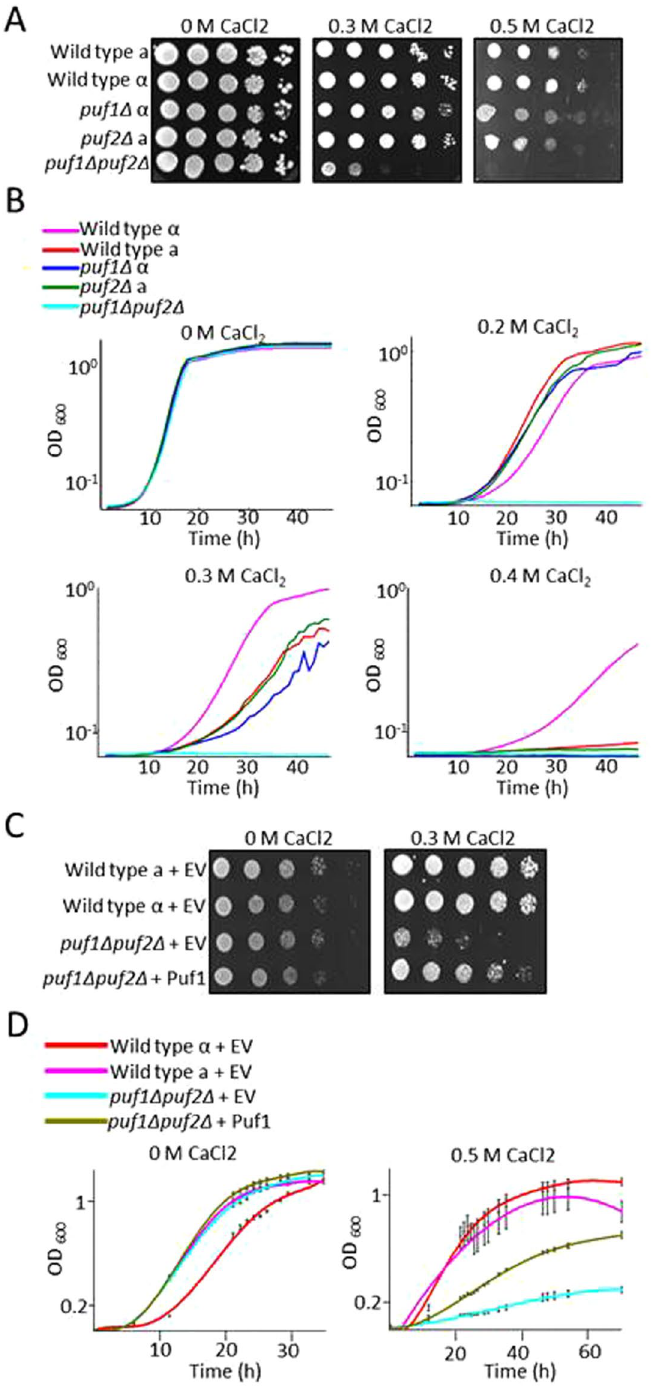
Figure 2. Puf1 and Puf2 deletions show distinct effects during growth under CaCl 2 stress. ( A ) Cells were grown in YPD to the stationary phase and diluted to OD 600 = 1. Five µ l of this suspension and four subsequent 10-fold serial dilutions of wild-type mating type ‘a’ (WT a)(yA635), wild-type mating type α (WT α , yA995), puf1 Δ (yA1382), puf2 Δ (yA637) and puf1 Δ puf2 Δ (yA639) strains were spotted onto YPD agar with the indicated CaCl 2 concentrations. Plates were incubated at 30 °C for one day without CaCl 2 or three days with CaCl 2 . ( B ) Mid-log- phase cells were diluted to OD 600 = 10 − 3 , and 200 µ l were aliquoted to 96-wells plates with the indicated CaCl 2 concentrations in YPD. OD 600 was measured automatically every 15 min. ( C ) WT ‘a’ with an empty vector (WT ‘a’ + EV (yA1306), WT α + EV (yA1419), puf1 Δ puf2 Δ + EV (yA1423) and puf1 Δ puf2 Δ with pPUF1 (yA1428), were spotted in 10-fold serial dilutions onto synthetic selection plates (SD) with the indicated CaCl 2 concentrations. The strains were incubated at 30 °C for two days without CaCl 2 or seven days with CaCl 2 . ( D ) Mid-log phase strains as in ( C ) were diluted to OD 600 = 10 − 2 ; 200 µ l of this suspension aliquoted to 96-wells plate with SD and proper selection media and the indicated CaCl 2 concentrations. OD 600 was measured at the indicated